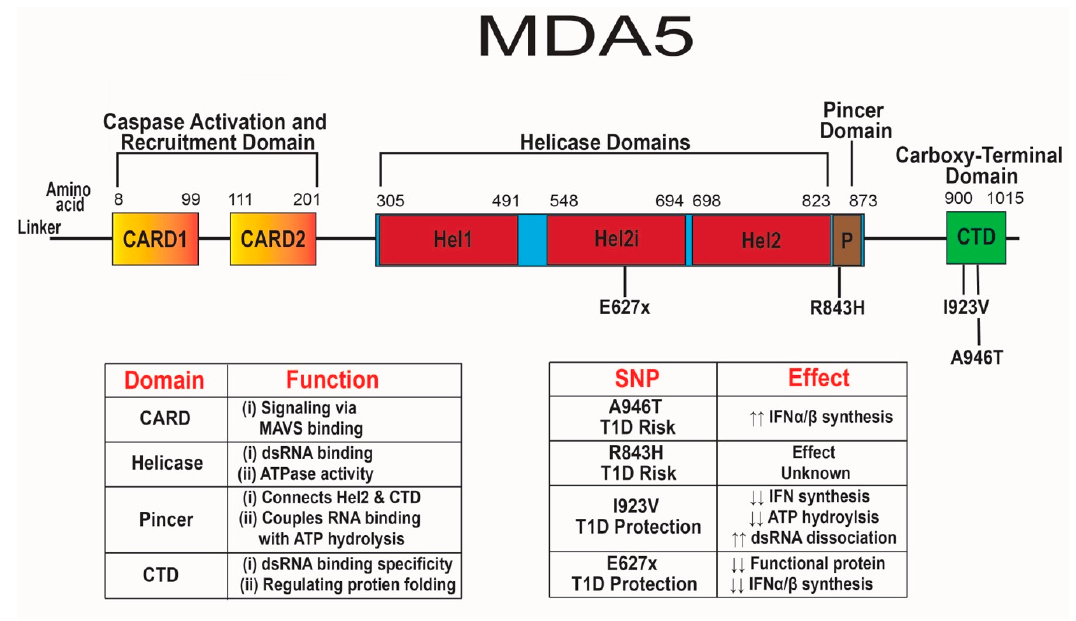
Figure 2. Diagram of melanoma differentiation-associated protein 5 (MDA5) functional domains and IFIH1 single nucleotide polymorphisms (SNPs). ↑↑ indicates increased functionality, whereas ↓↓ indicates decreased functionality. The N-terminal CARD domains of MDA5 are located between